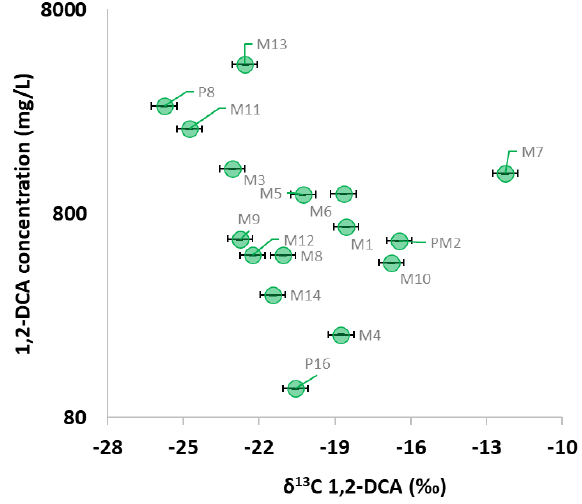
Figure 6. δ 13 C and concentrations data from the pilot area.